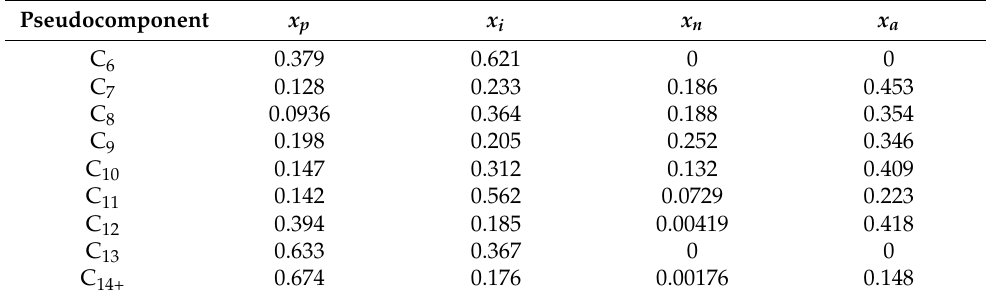
Table 10. Average PINA distribution for each pseudocomponent in the Lean gas type. The mole frac- tions of paraffins, isoparaffins, naphthenics and aromatics are denoted x p , x i , x n and x a , respectively. Pseudocomponent